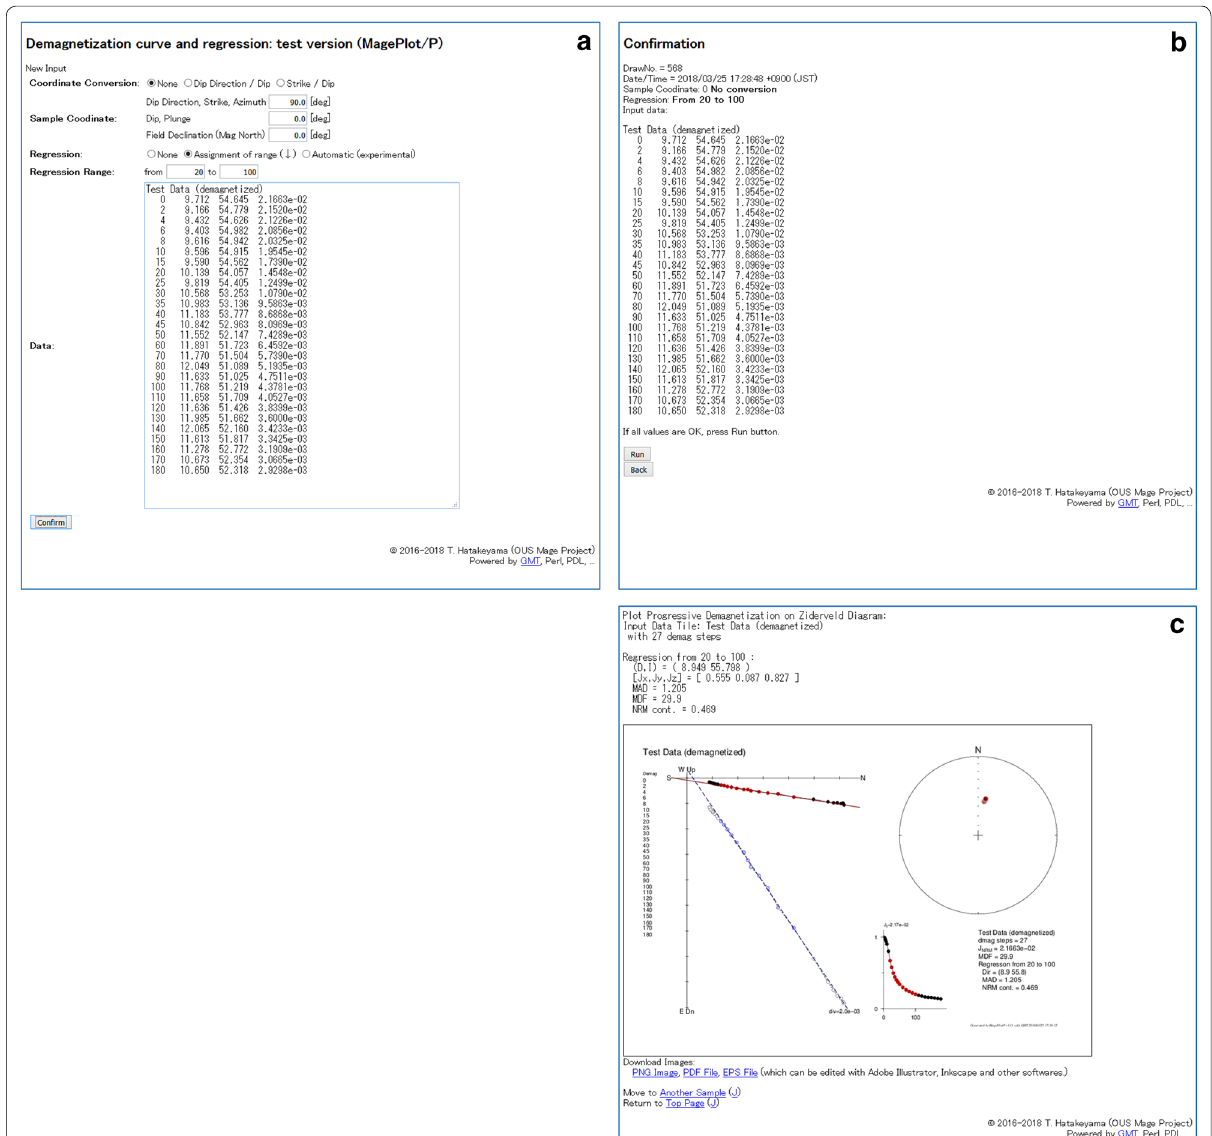
Fig. 2 Screenshots illustrating the use of the MagePlot/P service: a data and options input window, b confirmation window, and c results window. Links to download generated figures in PNG, PDF, and EPS formats are located in the lines below the figure. The top-right and bottom-right figures in the results window show the movement during demagnetization and the total intensity change,